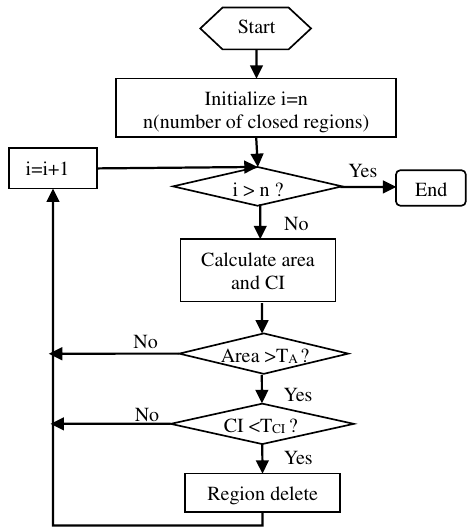
Fig. 4. The °owchart of the classify